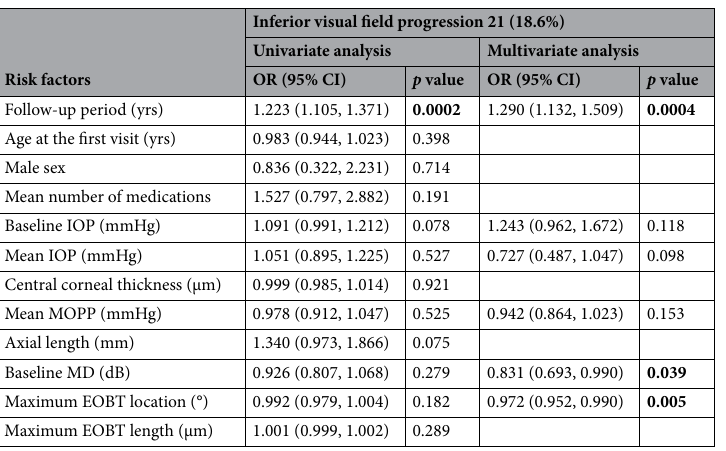
Table 5. Risk factors associated with visual field progression in the inferior hemifield. CI confidence interval, EOBT externally oblique border tissue, IOP intraocular pressure, MD mean deviation, MOPP mean ocular perfusion pressure. The best multiple logistic regression model was chosen based on the Akaike Information Criterion. Factors with statistical significance are marked in bold.